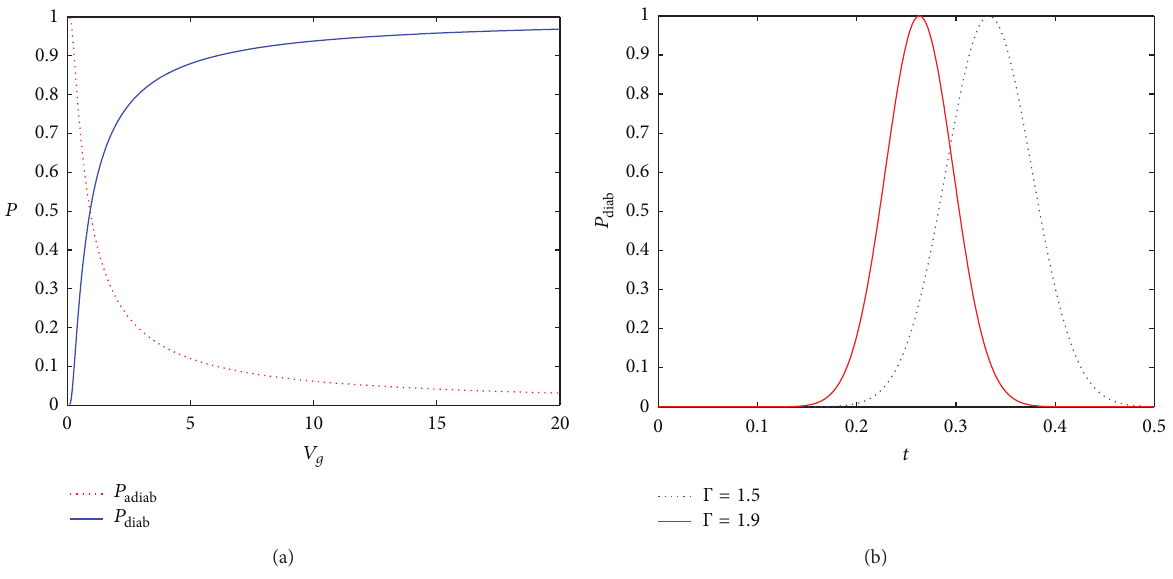
Figure 4: (a) LZ transition probability in the sudden (12) versus the group velocity, for diabatic (dot curves) and for adiabatic cases (solid curve); (b) LZ transition probability versus time for different values of the noise factor Γ